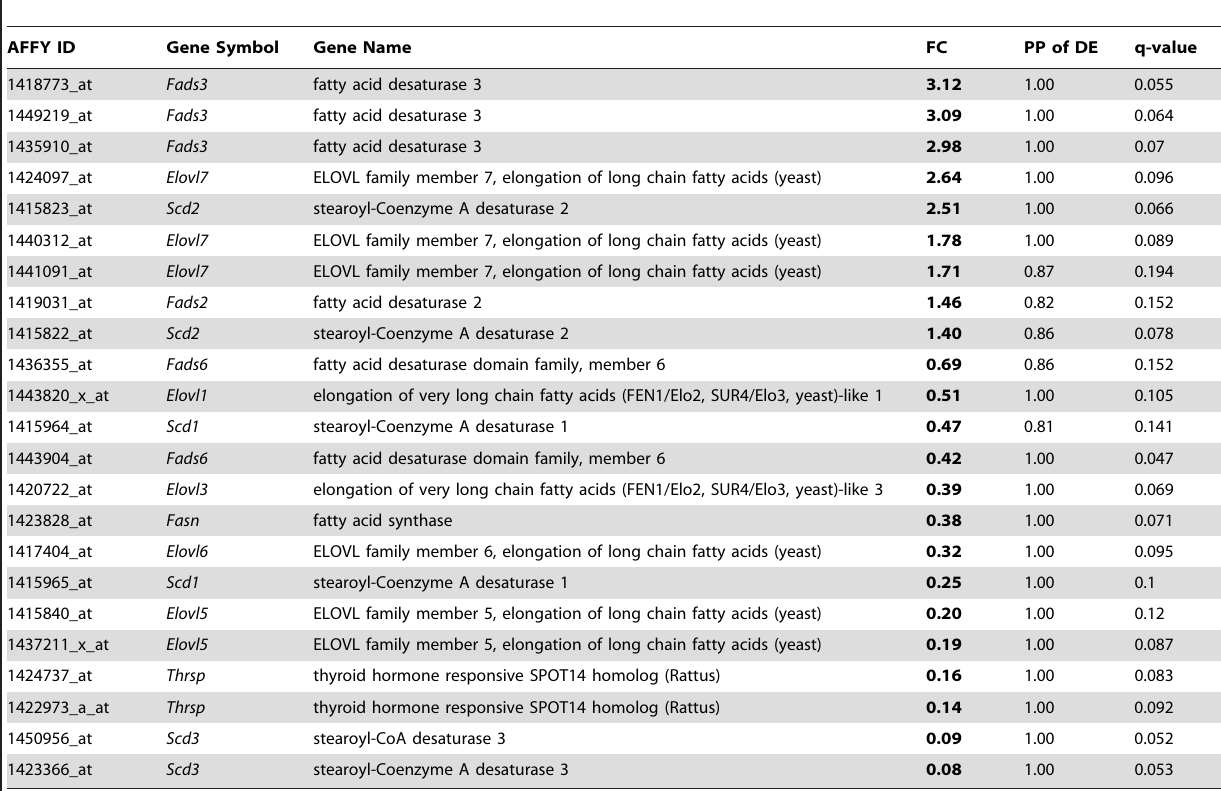
Table 8. Fatty acid synthesis, elongation and